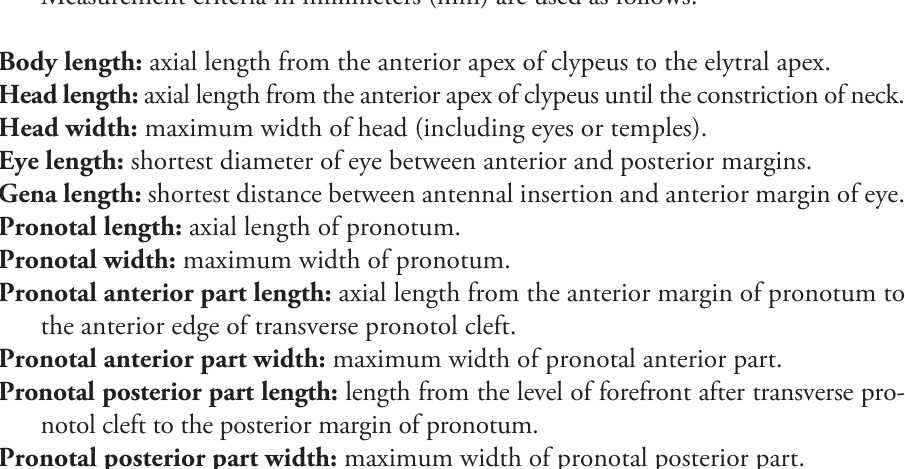
Body length: axial length from the anterior apex of clypeus to the elytral apex. Head length: axial length from the anterior apex of clypeus until the constriction of neck. Head width: maximum width of head (including eyes or temples). Eye length: shortest diameter of eye between anterior and posterior margins. Gena length: shortest distance between antennal insertion and anterior margin of eye. Pronotal length: axial length of pronotum. Pronotal width: maximum width of pronotum. Pronotal anterior part length: axial length from the anterior margin of pronotum to the anterior edge of transverse pronotol cleft. Pronotal anterior part width: maximum width of pronotal anterior part. Pronotal posterior part length: length from the level of forefront after transverse pro- notol cleft to the posterior margin of pronotum. Pronotal posterior part width: maximum width of pronotal posterior part. Elytral length: length from the basal border of elytra to its apex along suture. Elytral width: width across the middle of two elytra combined